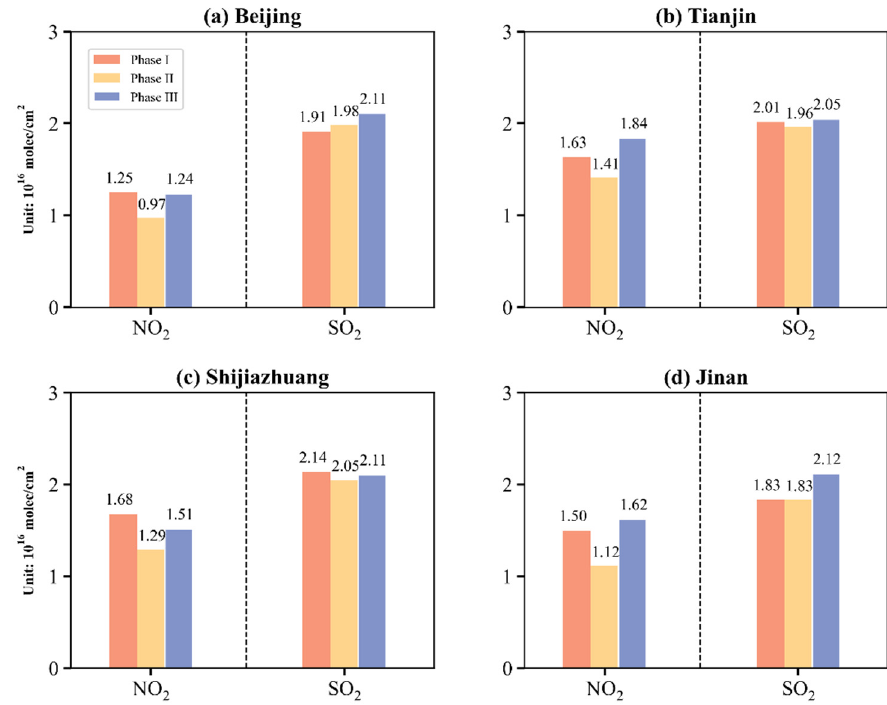
Figure 12. Bar graphs of NO 2 and SO 2 changes in three phases of four major capital cities: ( a ) Beijing, ( b ) Tianjin, ( c ) Shijiazhuang and ( d ) Jinan (units: 10 16 molec cm − 2 ).